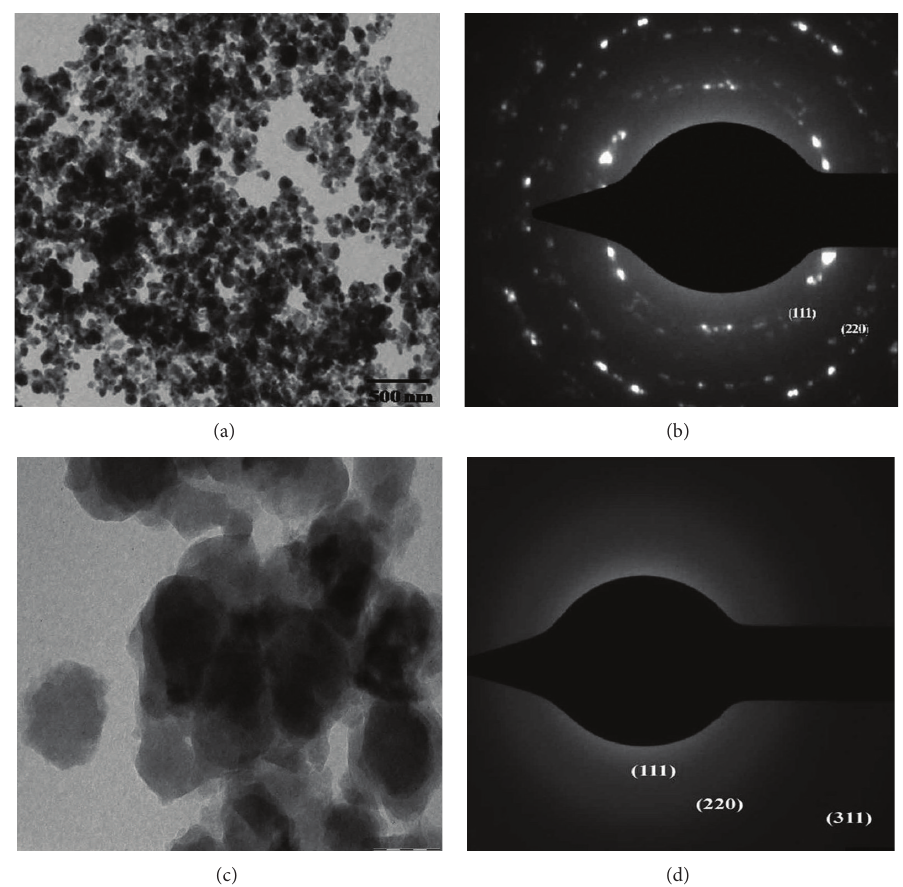
Figure 4: TEM image of synthesized sulfide nanoparticle by K. pneumoniae : (a) CdS and (b) ZnS, and SAED pattern of sulfide nanoparticle: (c) CdS and (d)